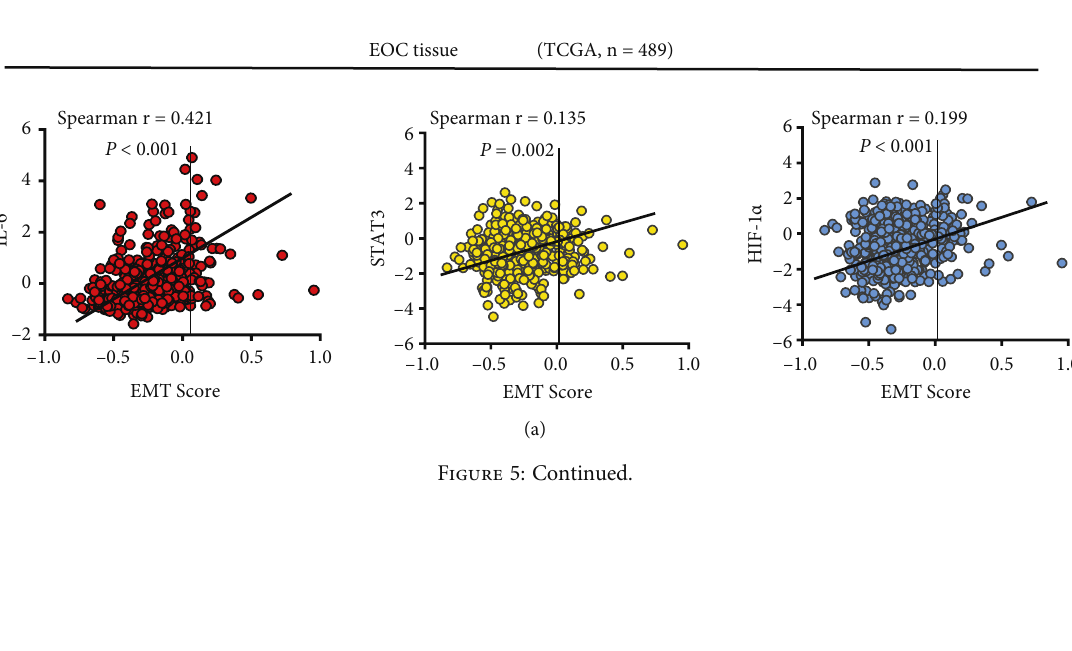
Figure 4: HIF-1 α inhibits the induction e ff ect of IL-6 on EMT and invasion. (a) Protein levels of EMT markers in transfected SKOV3 cells with repression of HIF-1 α after treatment with exogenous IL-6 (10 ng/ml) for 48 hours under normoxic conditions. (b) The invasion ability of transfected SKOV3 cells with repression of HIF-1 α was detected by Matrigel invasion assay after treatment as described for (a). Scale bars: 100 μ m. In each experiment, the numbers of cells that penetrated the membrane were counted in fi ve microscopic fi elds per fi lter. The invasion cell counts are presented as the mean ± SD of three independent experiments. * P < 0 : 05 compared with the SKOV3/scramble shRNA group and # P < 0 : 05 compared with the IL-6-treated SKOV3/scramble shRNA group by one-way ANOVA with LSD multiple comparison